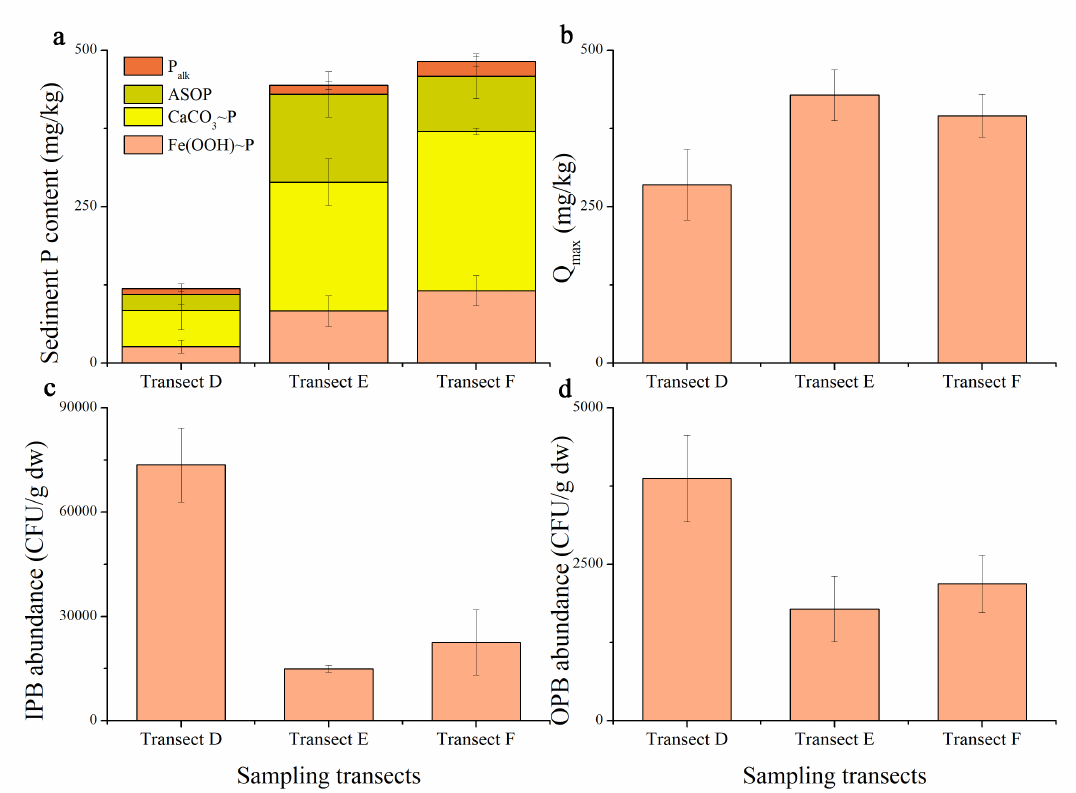
Figure 6. Di ff erent forms of P content ( a ), Q max ( b ), inorganic P − solubilizing bacteria (IPB) ( c ), and organic P − mineralizing bacteria (OPB) abundance ( d ) in the sediment in the northern region of Taiwan Strait.